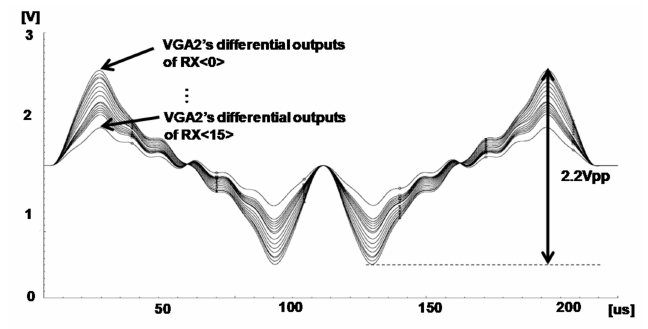
Figure 24. Transient simulation outputs of the VGA2 in the 16th RX